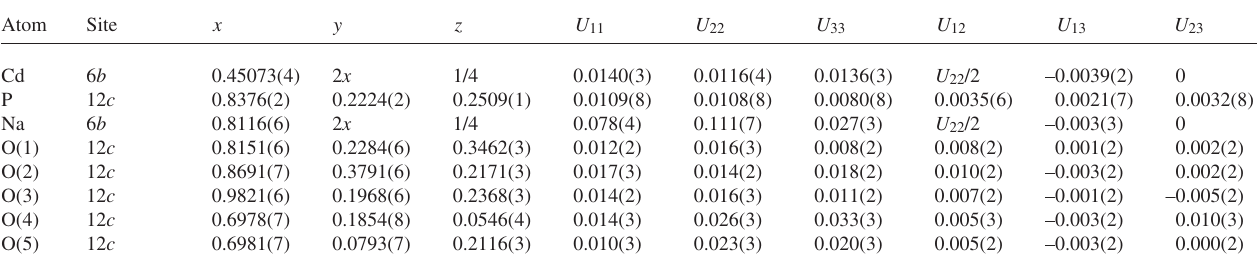
Table 3. Atomic coordinates and displacement parameters (in Å 2 )